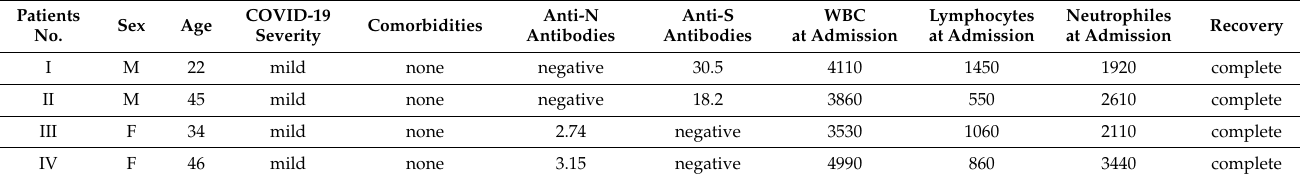
Table 1. Characteristics of four patients with conflicting results of immunological tests. Patients